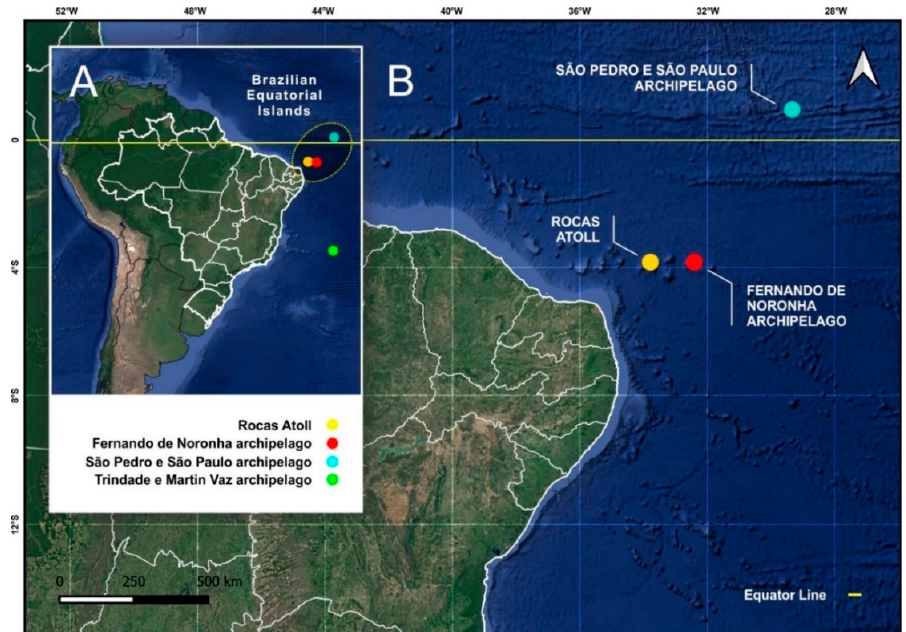
Figure 1. Brazilian oceanic islands. ( A ). Geographical position of all Brazilian oceanic islands showing the equatorial islands. ( B ). Details of the geographic position of the Brazilian equatorial oceanic islands.